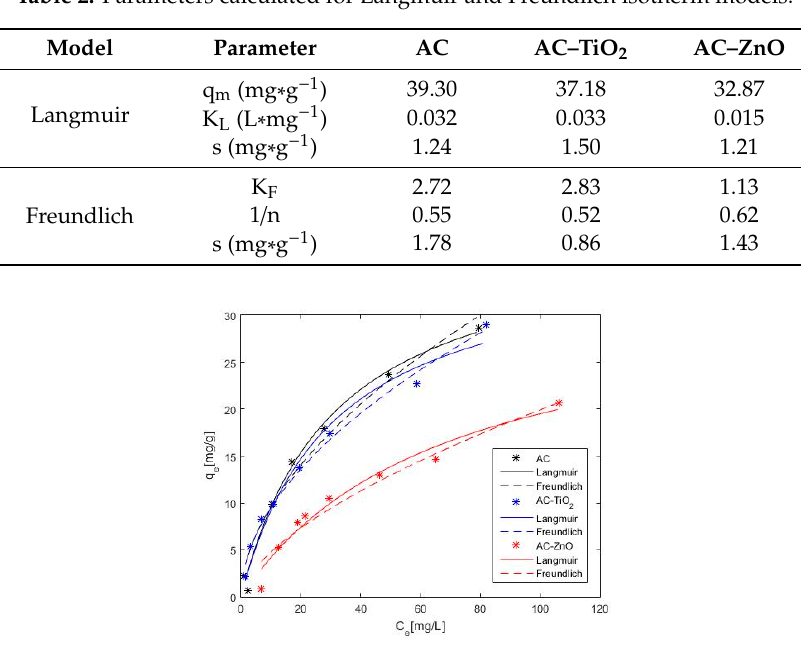
Figure 7. Adsorption isotherms of phenol at 298 K. Table 2. Parameters calculated for Langmuir and Freundlich isotherm models.